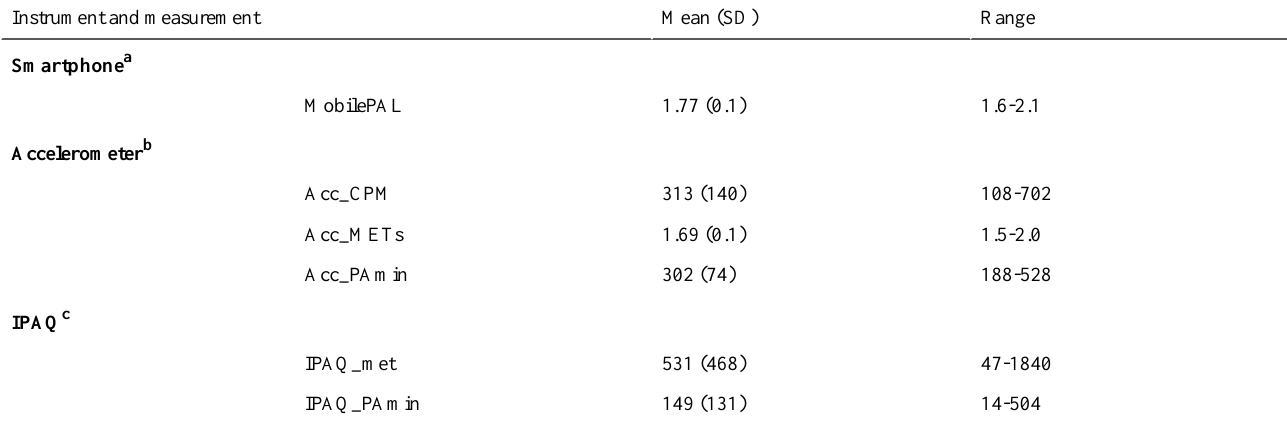
Table 3. Summary of average daily physical activity obtained by the 3 different instruments, the smartphone, the accelerometer, and the International Physical Activity Questionnaire